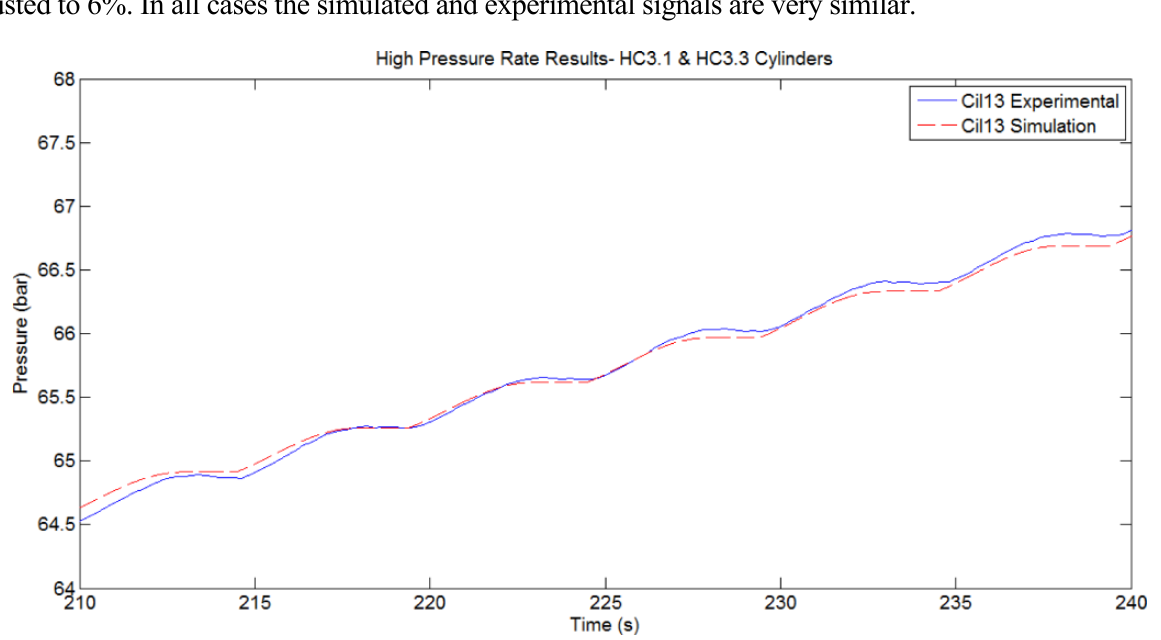
Figure 22. Comparison between Simulated and Experimentally Measured pressure of HP Accumulator. Active cylinders HC3.1 and HC3.3. Initial Pres. 64.5 bar. Geometrical layout: Config 1.